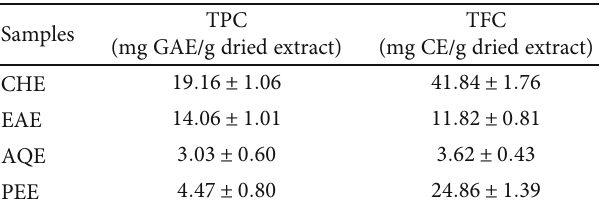
Table 2: Total phenolic and fl avonoid contents of di ff erent extracts from E . fl uctuans